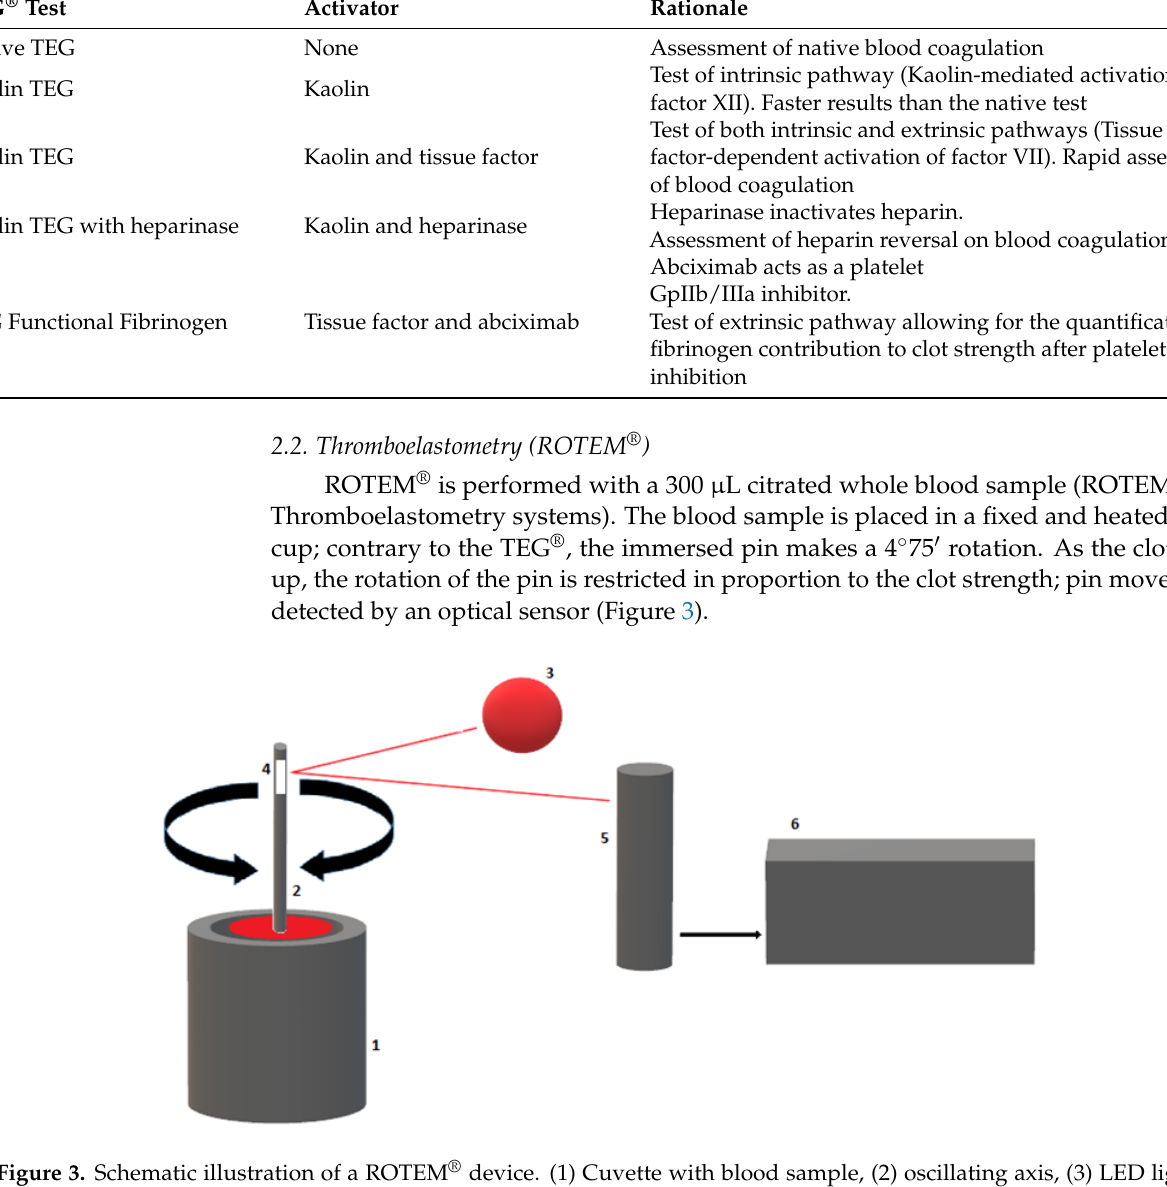
Figure 4. Illustration of thromboelastometry (ROTEM ® ) tracing and the accompanying parameters.